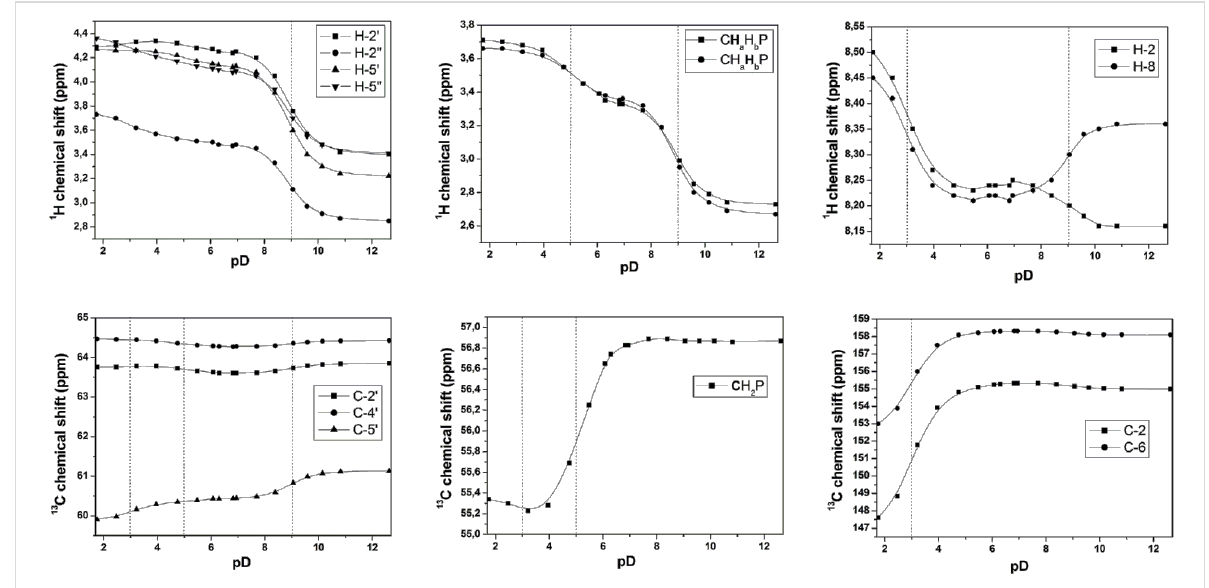
Figure 5: Changes of selected 1 H and 13 C chemical shifts of 9 upon pD change.